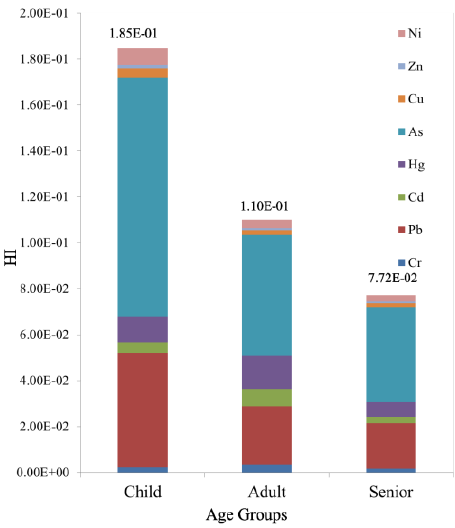
Figure 3. H azard indices ( His) of different age groups.